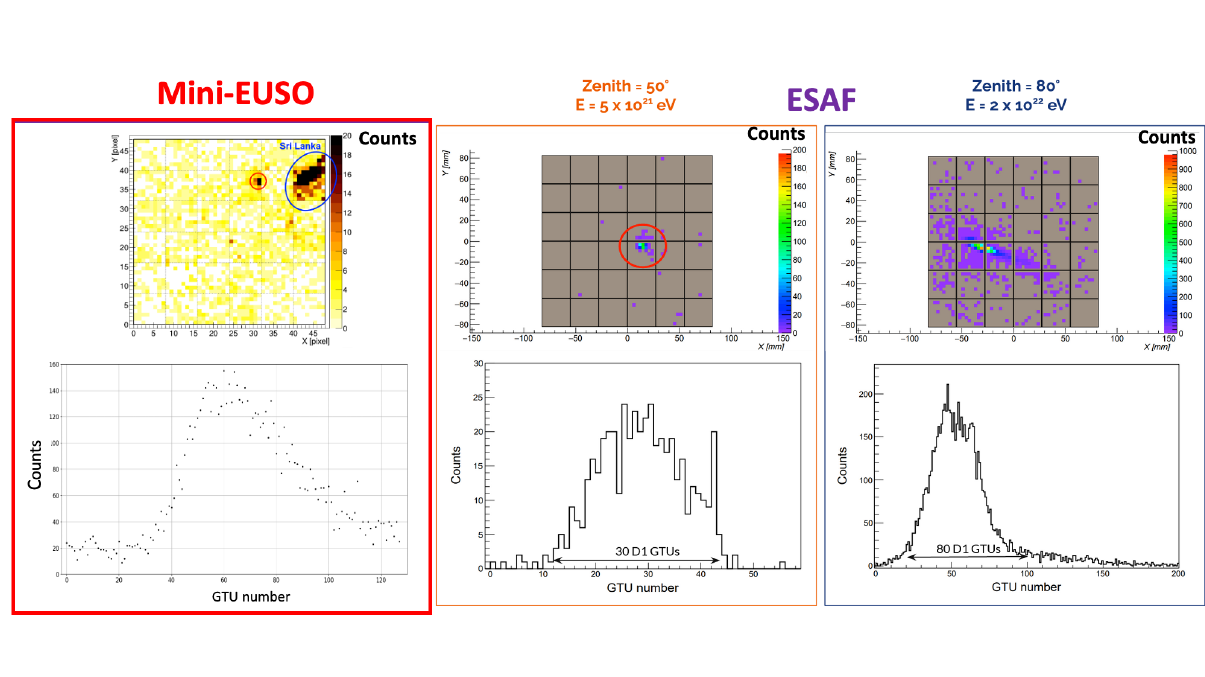
Figure 8. Upper left panel: one frame of an event triggered o ff the coast of Sri Lanka. The blue circle (upper right) encloses a static, bright light source. The trigger was issued by the event in the red circle. Bottom left panel: the lightcurve of a 3 × 3 pixel box that contains the event. The lightcurve presents the characteristic bi-gaussian shape, with a faster rise and a slower decay time. Central and right panels: Two proton-generated EAS simulated with ESAF at two di ff erent energies and zenith angles (top part presents the image of the events while the bottom part the corresponding lightcurves). The central panel shows a simulation at zenith θ = 50 ◦ and energy E = 5 × 10 21 eV. The signal persists in few pixels for ∼ 30 GTUs, much shorter than the one of measured ground source, the sharp cuto ff is given by the shower reaching the ground. The right panel is a simulation with θ = 80 ◦ and primary energy E = 2 × 10 22 eV. The signal is much longer in time but the footprint on the focal plane is much more elongated. Image adapted from